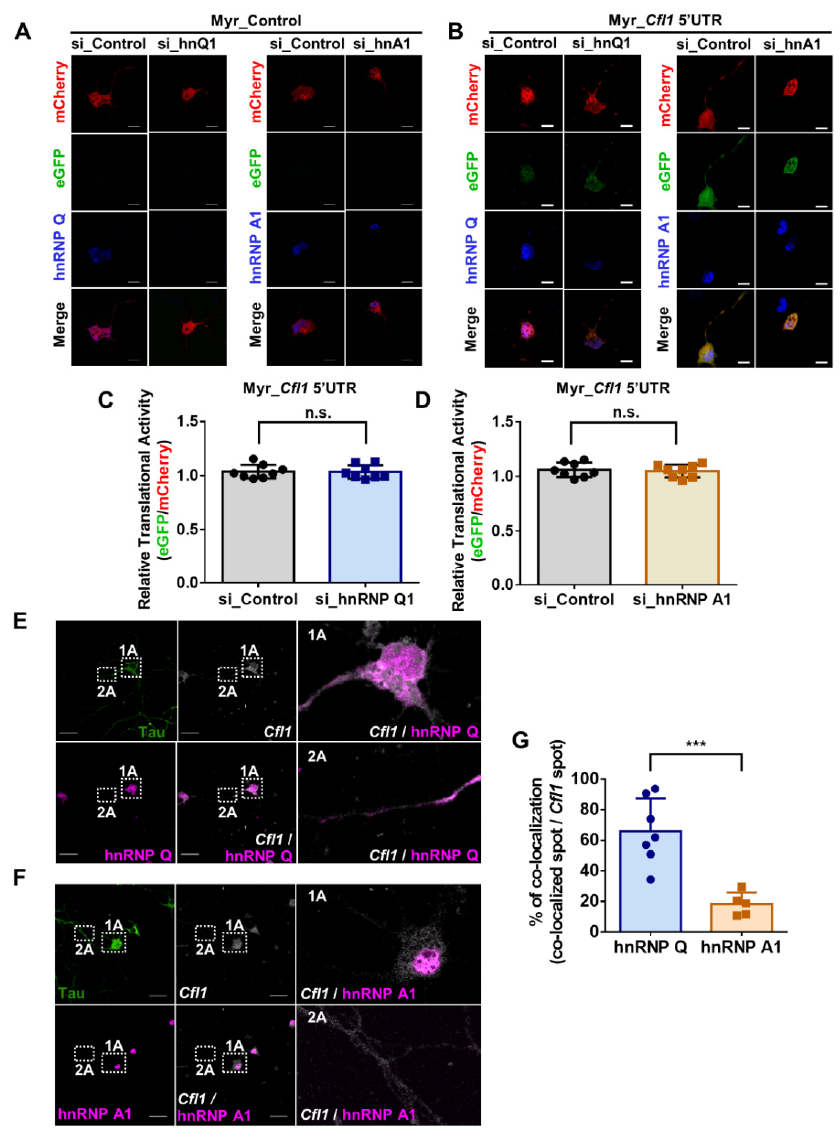
Figure 4. The translational activity of Cfl1 mRNA in primary hippocampal neurons is unaffected by hnRNP Q and hnRNP A1 under normal conditions. ( A , B ) Measurement of the translational activity of Cfl1 mRNA in primary hippocampal neu- ron that was transfected with si_Control (first and third column), si_hnRNP Q1 (second column) or si_hnRNP A1 (fourth column), with co-transfection of mCherry (red)/eGFP (green) bicistronic vector with ( B ) or without ( A ) Cfl1 5 ′ UTR se- quences. HnRNP Q (blue) and hnRNP A1 (blue) were stained by their corresponding antibodies. Scale bar = 10 μ M. ( C ) Quantification of relative translational activity of Cfl1 mRNA in hippocampal neurons transfected with si_Control (gray) or si_hnRNP Q1 (blue) by measuring the eGFP/mCherry ratio. n.s., not significant; unpaired Student’s t test ( n = 8). ( D ) Quantification of relative translational activity of Cfl1 mRNA in hippocampal neurons transfected with si_Control (gray) or si_hnRNP A1 (orange), by measuring the eGFP/mCherry ratio. n.s., not significant; unpaired Student’s t test ( n = 8). ( E ) The co-localization between Cfl1 mRNA and hnRNP Q was observed by the immunofluorescence labeling of hnRNP Q (magenta) and Tau (green), along with RNA fluorescence in situ hybridization (RNA FISH) of Cfl1 mRNA (white) using Stellaris™ RNA FISH. The co-localization of hnRNP Q and Cfl1 mRNA in soma (1A) and axon (2A) of the neuron is shown through scaled-up images. Scale bar = 30 μ M. (F) The co-localization between Cfl1 mRNA and hnRNP A1 was observed by the immunofluorescence labeling of hnRNP A1 (magenta) and Tau (green), along with RNA fluorescence in situ hy- bridization (RNA FISH) of Cfl1 mRNA (white) using Stellaris™ RNA FISH. The co-localization of hnRNP A1 and Cfl1